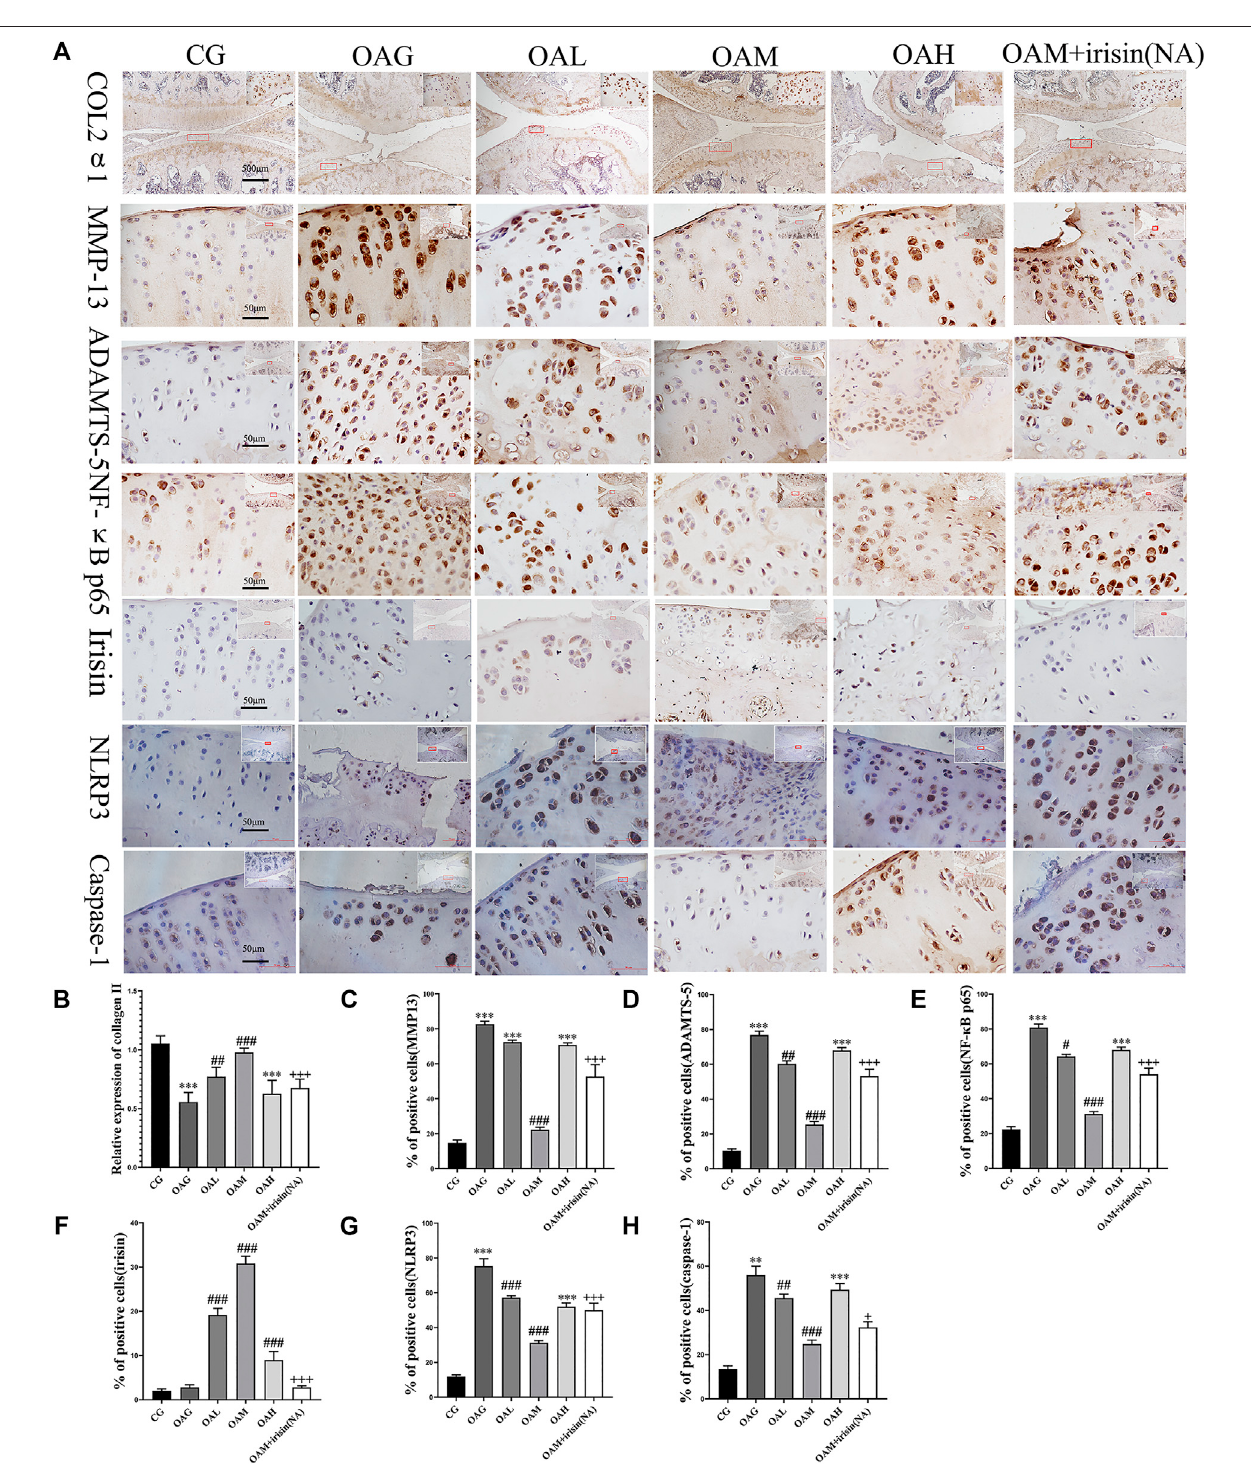
FIGURE 4 | Immunohistochemical staining in OA rats subjected to different treadmill exercise protocols. (A,B) The expression of collagen II in CG, OAM, and OAL was higher than that in OAH and OAG. (A,C) The percentage of MMP-13 positive cells in CG and OAM was lower than that in OAH, OAG, and OAL. (A,D) The percentage of ADAMTS-5 positive cells in CG and OAM was lower than that in OAH and OAG. (A,F) The percentage of irisin positive cells in OAL, OAM, and OAH was higher than thatin CGand OAG. (A,G) Thepercentage ofNLRP3 positivecells inOAL, OAM, and OAH waslower than that inCGand OAG. (A,H) Thepercentage of caspase-1 positive cells in OAL, OAM, and OAH was lower than that in CG and OAG. However, the therapeutic effects of moderate-intensity treadmill exercise could be suppressed by irisin neutralizing antibodies. Data were expressed as the mean ± SEM. * p < 0.05 vs. CG; ** p < 0.01 vs. CG; *** p < 0.001 vs. CG. # p < 0.05 vs. OAG; ## p < 0.01 vs. OAG; ### p < 0.001 vs. OAG. + p < 0.05 vs. OAM; ++ p < 0.01 vs. OAM; +++ p < 0.001 vs. OAM. n = 5, means ±95% CI.